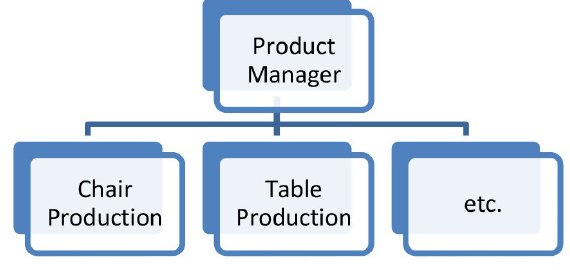
Figure 3. Product based organizational scheme